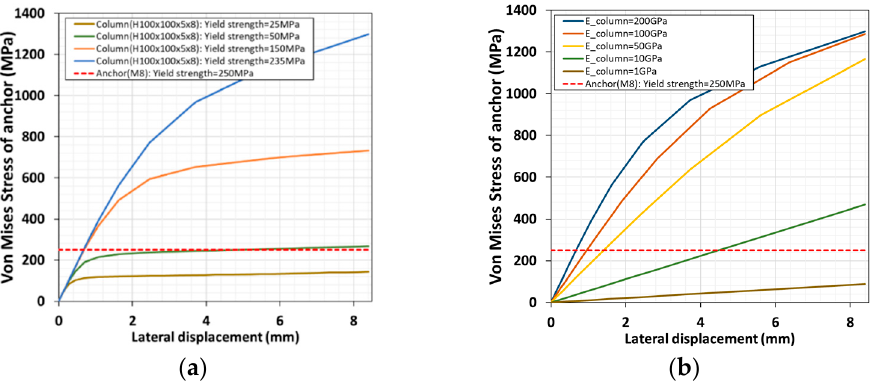
Figure 9. Pushover simulations. Maximum anchor von-Mises stress vs. lateral displacement under different ( a ) column yield strengths and ( b ) column elastic stiffnesses.